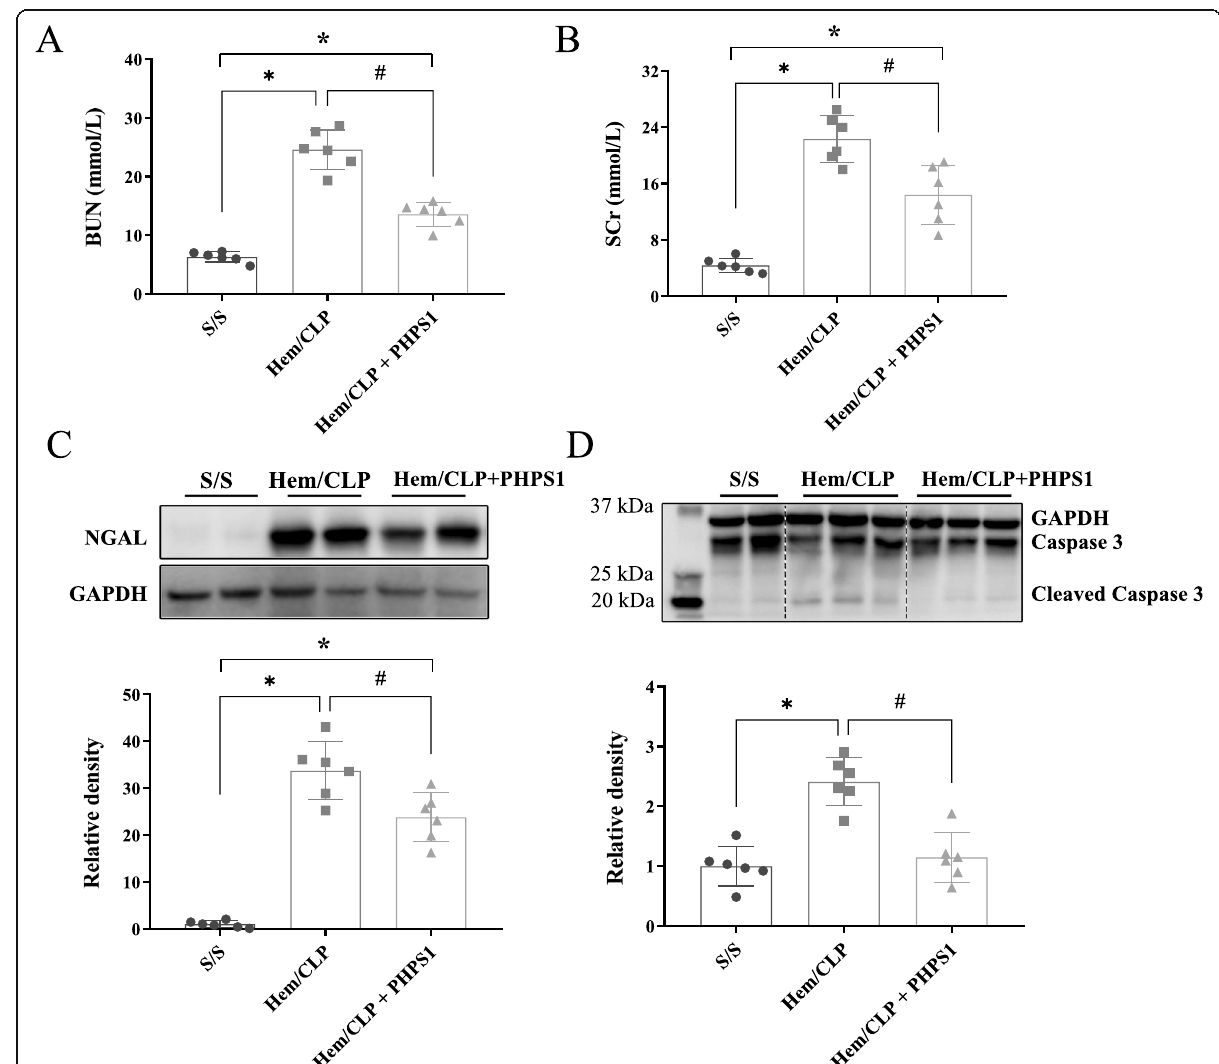
Fig. 3 Effects of SHP2 inhibition by PHPS1 treatment on kidney injury after Hem/CLP. The plasm samples were collected 24 h post Hem/CLP or Sham operation for urea nitrogen (BUN) ( a ), creatinine (SCr) ( b ), NGAL ( c ) and cleaved caspase 3 ( d ). Vehicle treated Hem/CLP mice showed significantly increased in BUN, SCr, NGAL and cleaved caspase 3 levels compared to Sham mice. However, these increases were markedly reduced in PHPS1 treated Hem/CLP mice. *, P < 0.05, versus Sham (S/S); #, P < 0.05, PHPS1 treated group (Hem/CLP + PHPS1) versus Hem/CLP+ vehicle (Hem/CLP). One-way ANOVA and a Student-Newman-Keuls ’ test, Mean ± SD; n = 6